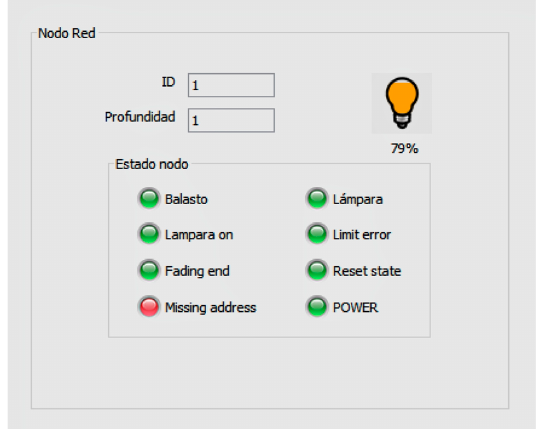
Figure 6. Detail of the information window of a lamp.